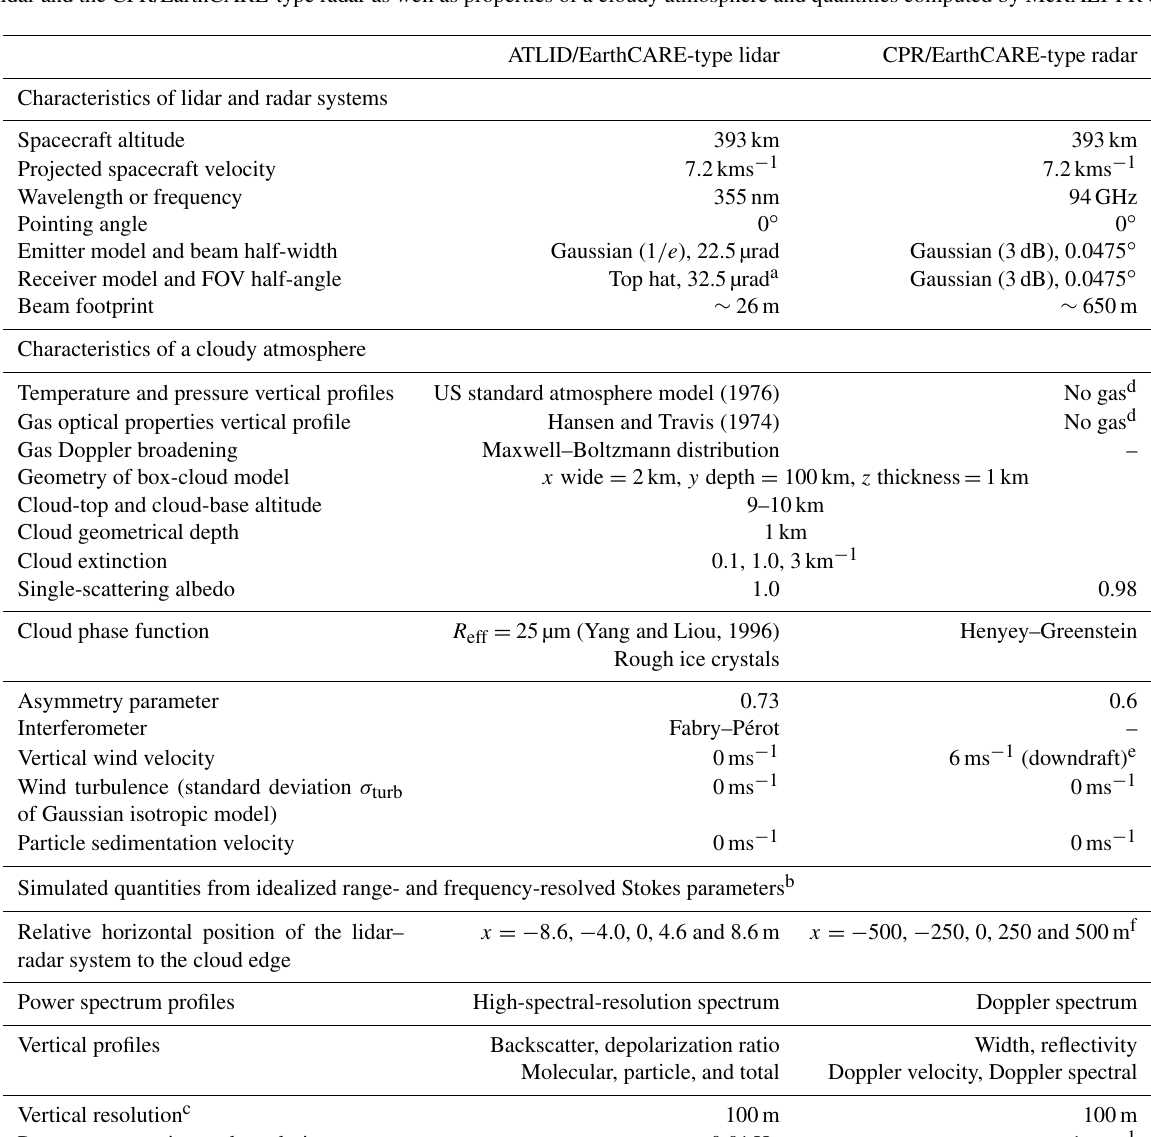
Table 1. Description of the simulation conditions presented in this work. This table summarizes the characteristics of the ATLID/EarthCARE- type lidar and the CPR/EarthCARE-type radar as well as properties of a cloudy atmosphere and quantities computed by McRALI-FR